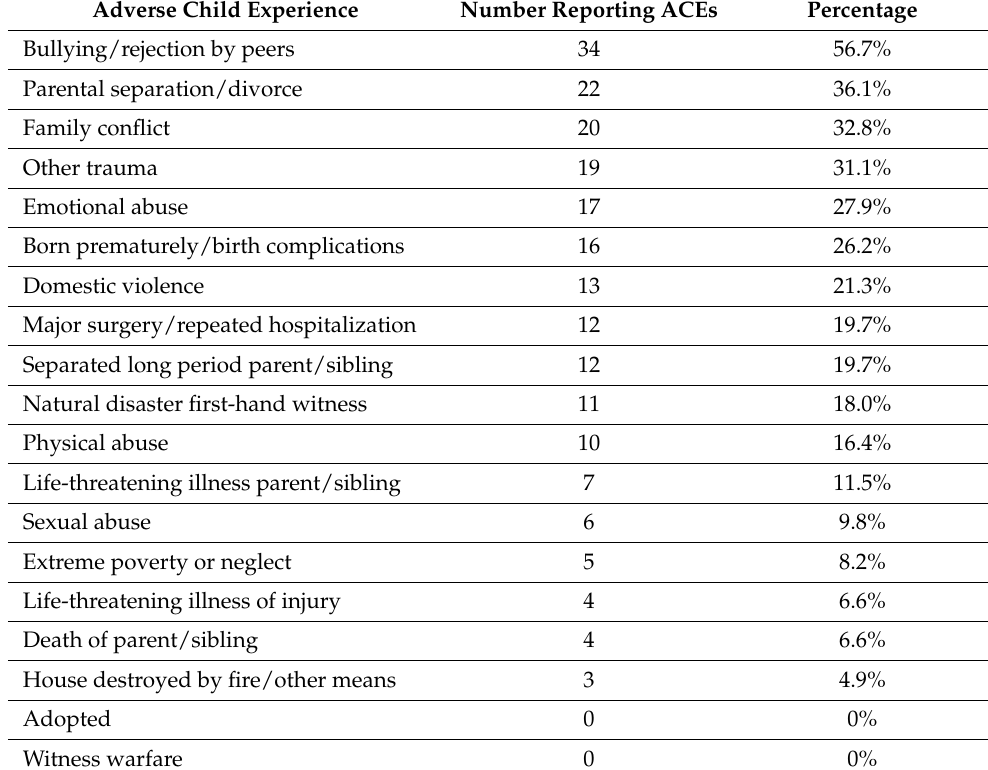
Table 1. Adverse childhood experiences reported by young people with FND ( n = 60) * on the ELSQ on admission to the Mind–Body Program for treatment and for participation in the FND Research